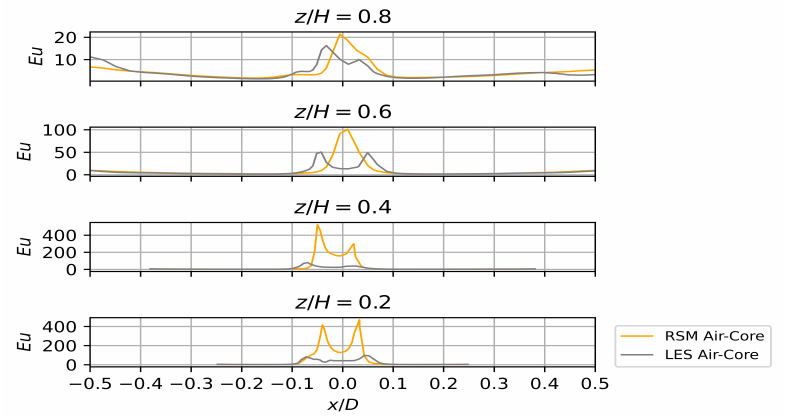
Figure 21. Vorticity magnitude (1/s) for the RSM and LES models as a function of the normalised x co-ordinate at various heights at flow-time 4 s for the simulations with the particles included and at flow-time 2 s for the air-core only simulations.